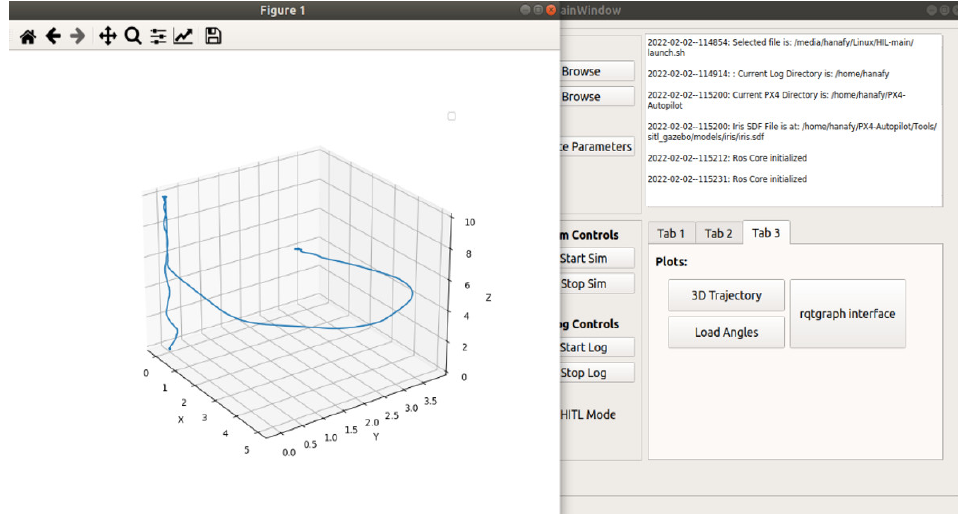
Figure 13. PX4 parameters manipulator.